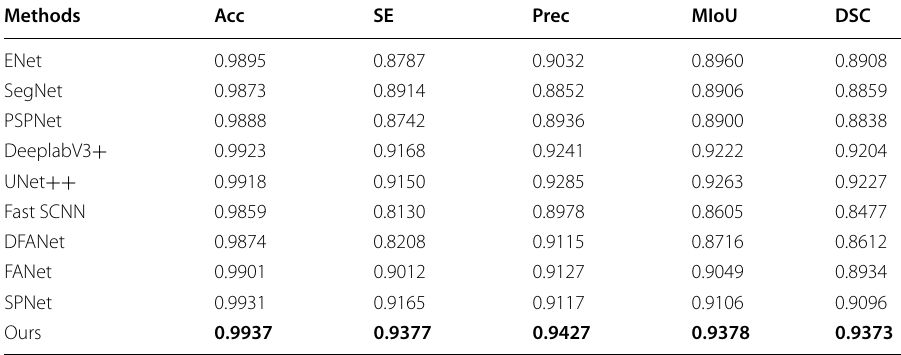
Table 1 Quantitative results of pulmonary nodule segmentation in which highlighted values represent the best result of each metric